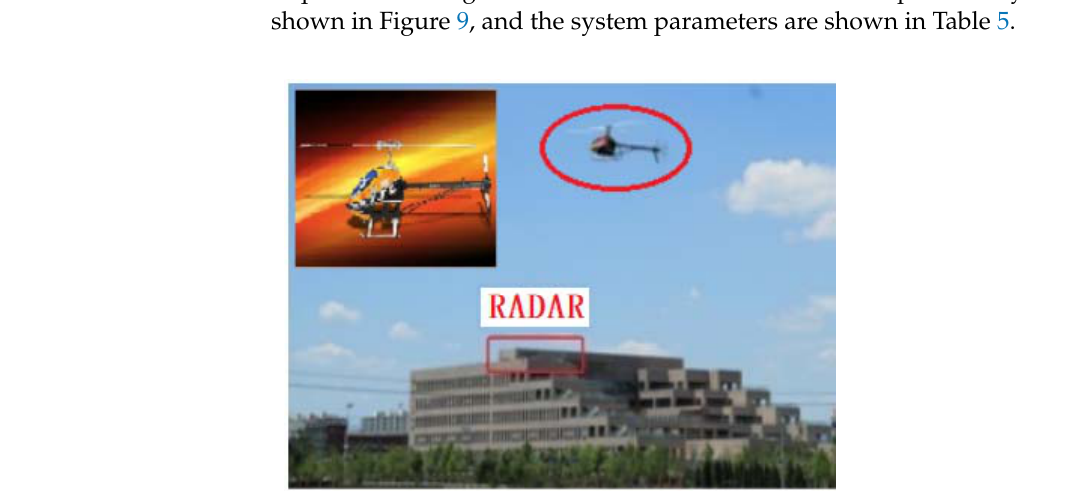
Figure 9. Data acquisition system. Table 5. Radar and Target